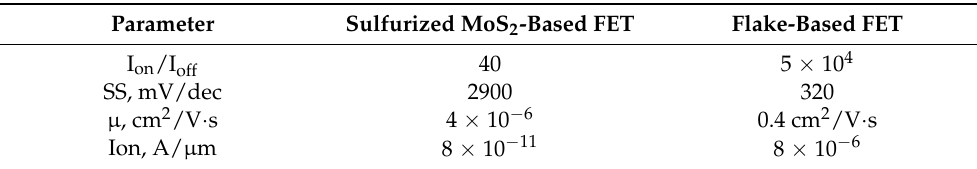
Table 1. FET structures performance parameters for sulfurized MoS 2 -based FETs and flake-based FETs.